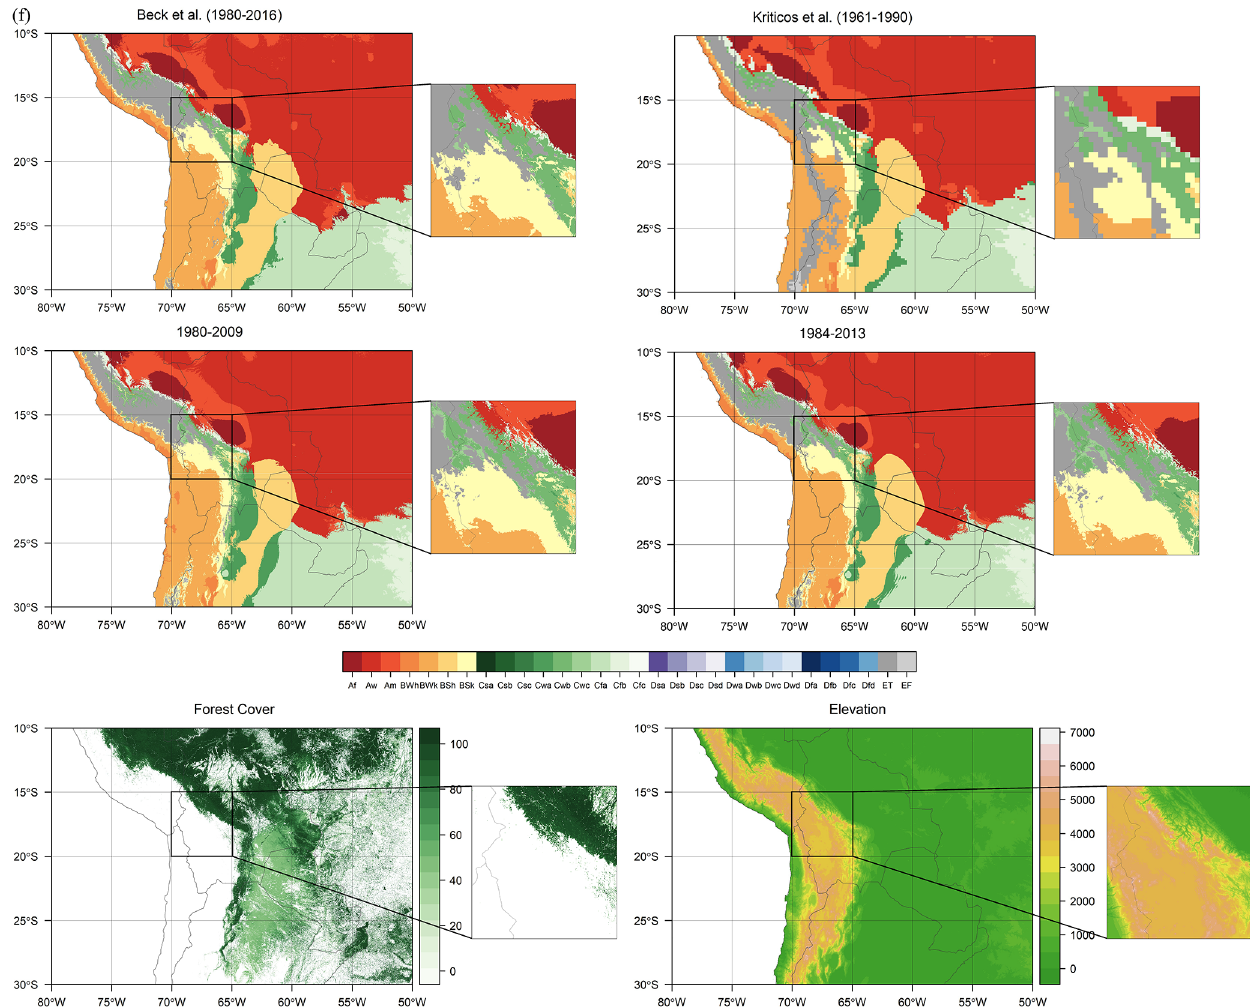
Figure 8. Köppen–Geiger climate classification maps from previous studies, Beck et al. (2018, 1km, 1980–2016) and Kriticos et al. (2012, 0.167 ◦ , 1961–1990), and our study (1km, 1979–2009 to 1984–2013) and associated forest cover and elevation maps, for regions with large spatial gradients in climates or sharp elevation gradients. (a) Central Rocky Mountains, (b) Tibetan Plateau, (c) Europe, (d) high latitudes in North America, (e) central and eastern Africa, and (f) central Andes. The forest cover map is the 30m Landsat-based forest cover map for the year 2000 (Hansen et al., 2013). The elevation data are the NASA SRTM Digital Elevation 30m data (Farr et al., 2007). The representative period of each map is listed in